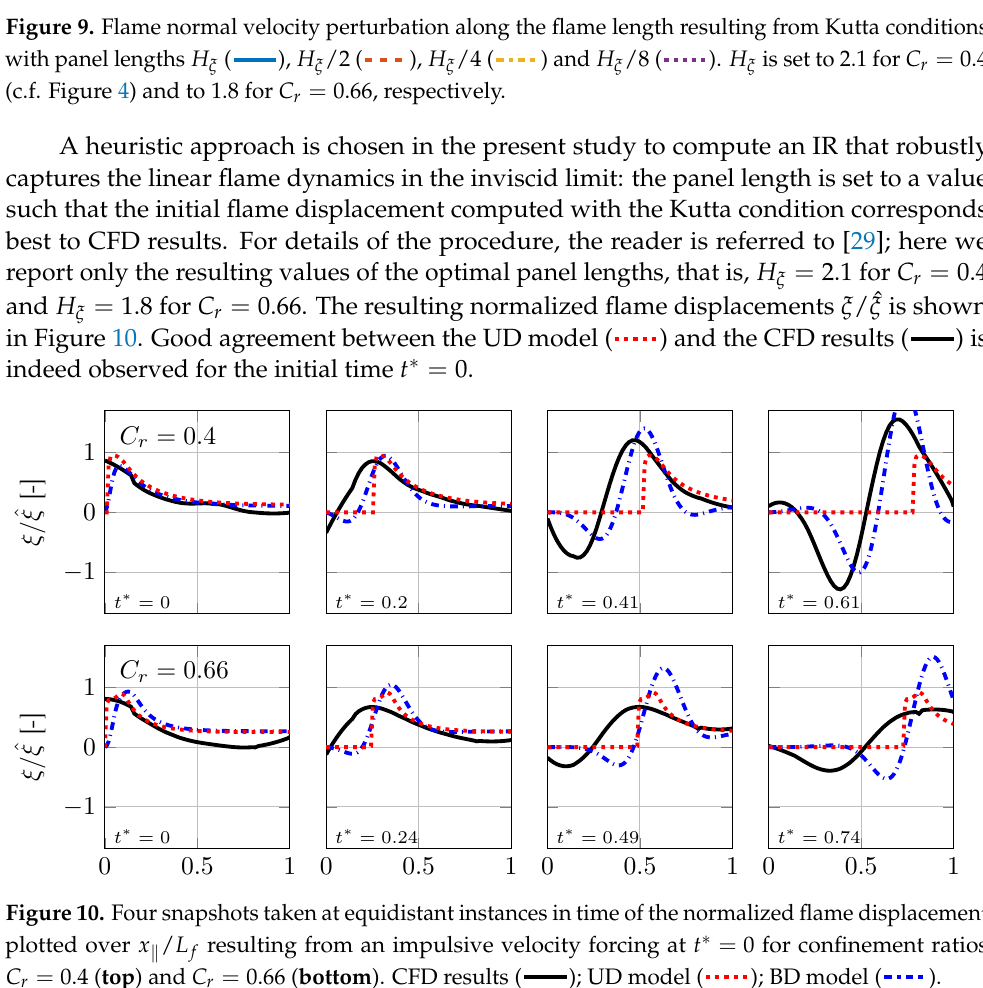
flame tip, until eventually the original flame shape is restored [10]. Figure 10 shows that with the UD model the shape of the displacement does not change during the restoration process. On the contrary, the CFD results exhibit a spatial growth of the initial displacement amplitude as well as subsequent negative as well as positive